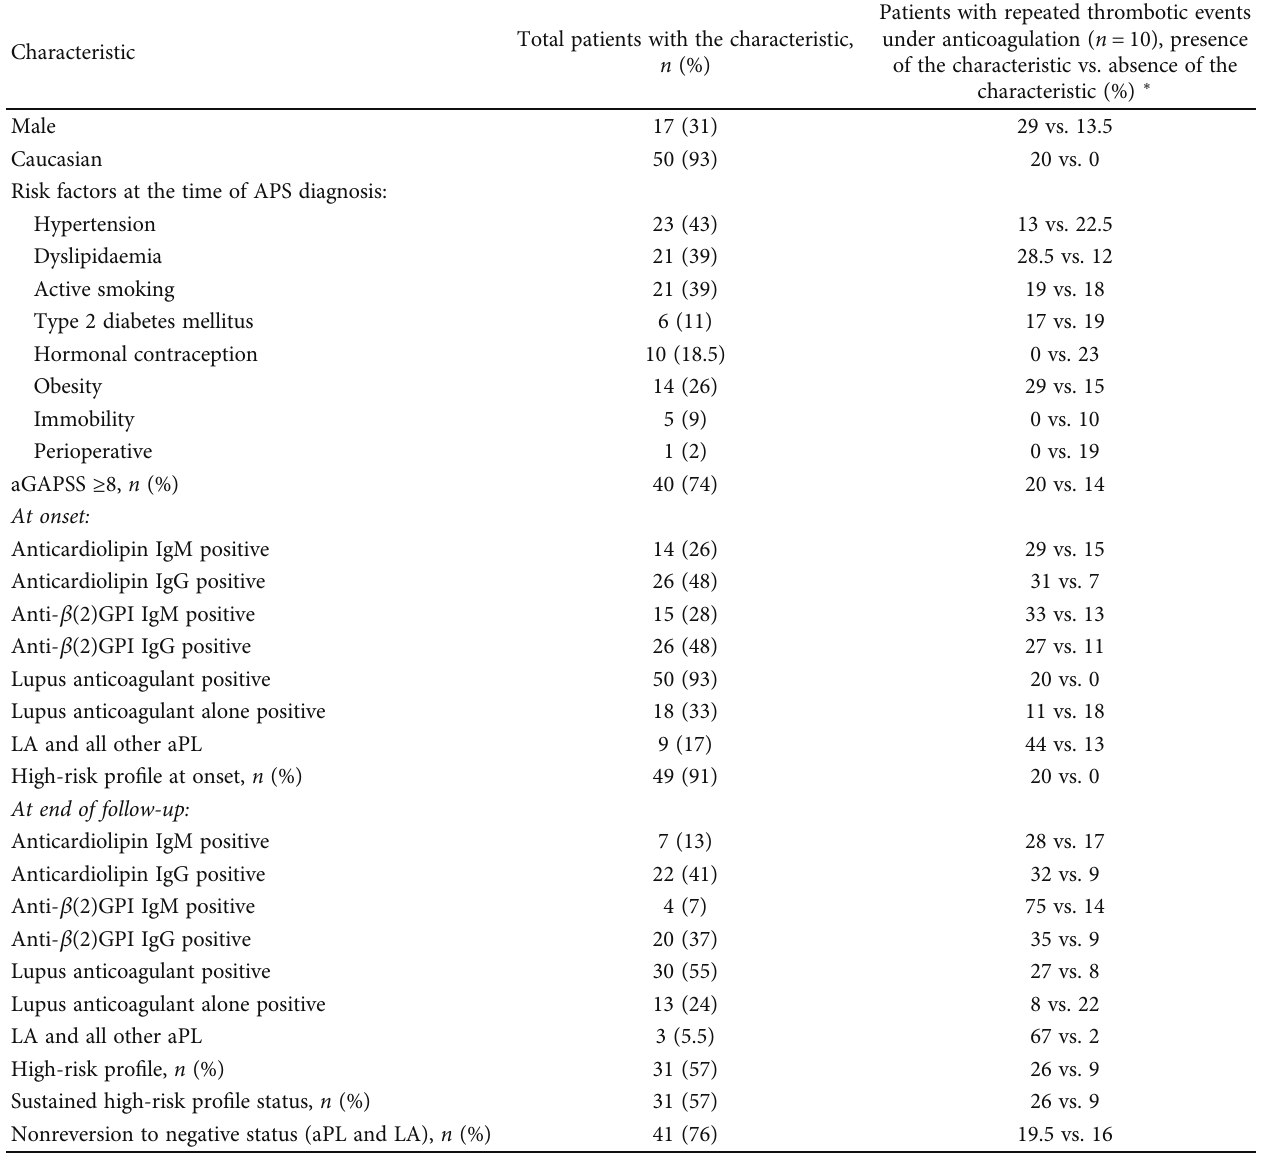
Table 2: Demographic, clinical, and laboratory parameters and risk pro fi le at onset and end of follow-up, according to the occurrence or not of repeated thrombotic events in patients under anticoagulation, presence of the characteristic versus absence of the characteristic (%). Total patients with the characteristic, Characteristic n